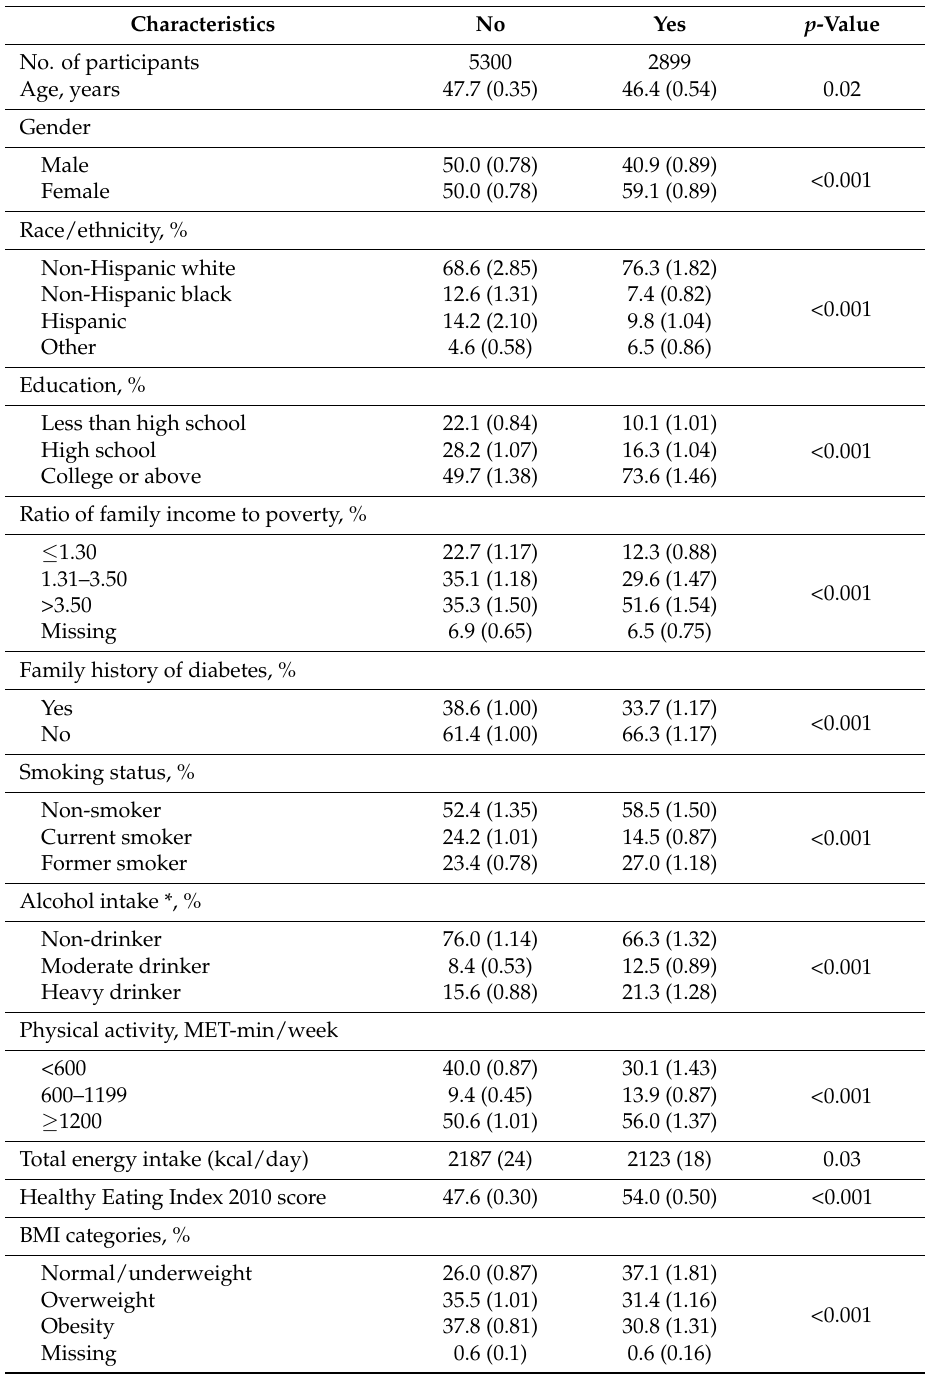
Table 1. Characteristics among 8199 participants in the National Health and Nutrition Examination Survey (NHANES) 2007–2010, according to their purchase of organic